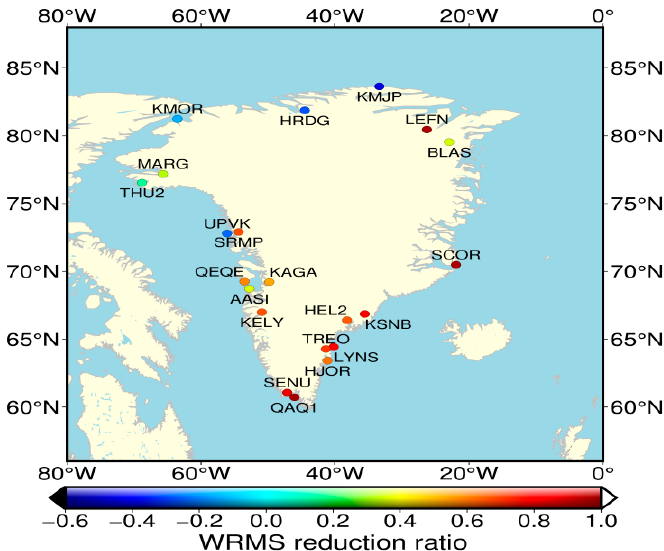
Figure 12. WRMS reduction ratio of GPS station coordinates corrected by GRACE data.